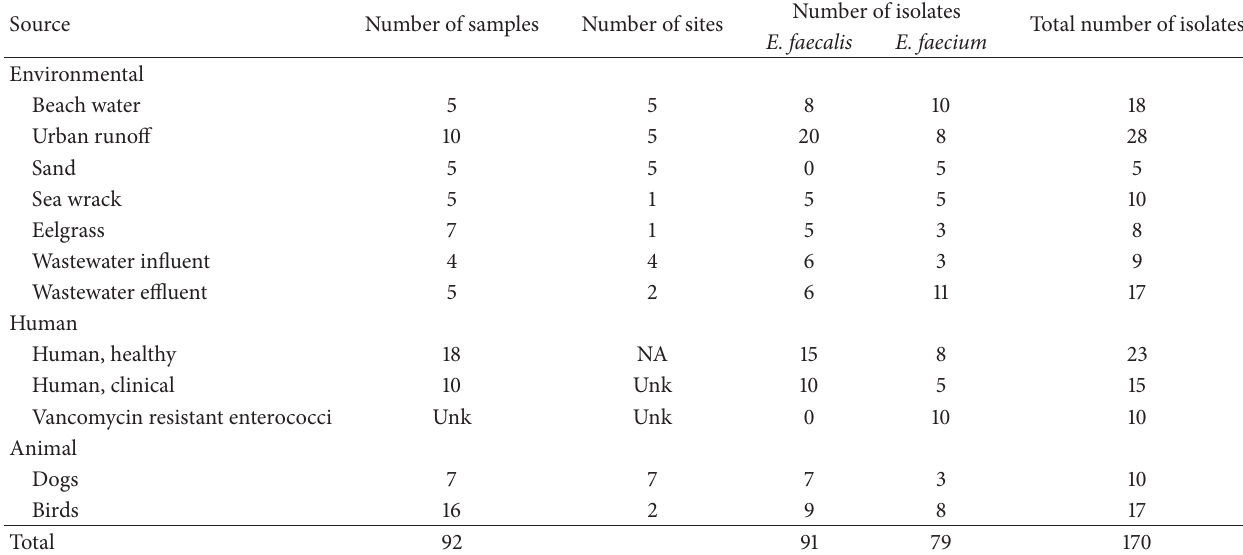
Table 1: Sources of E. faecalis and E. faecium isolated from Southern